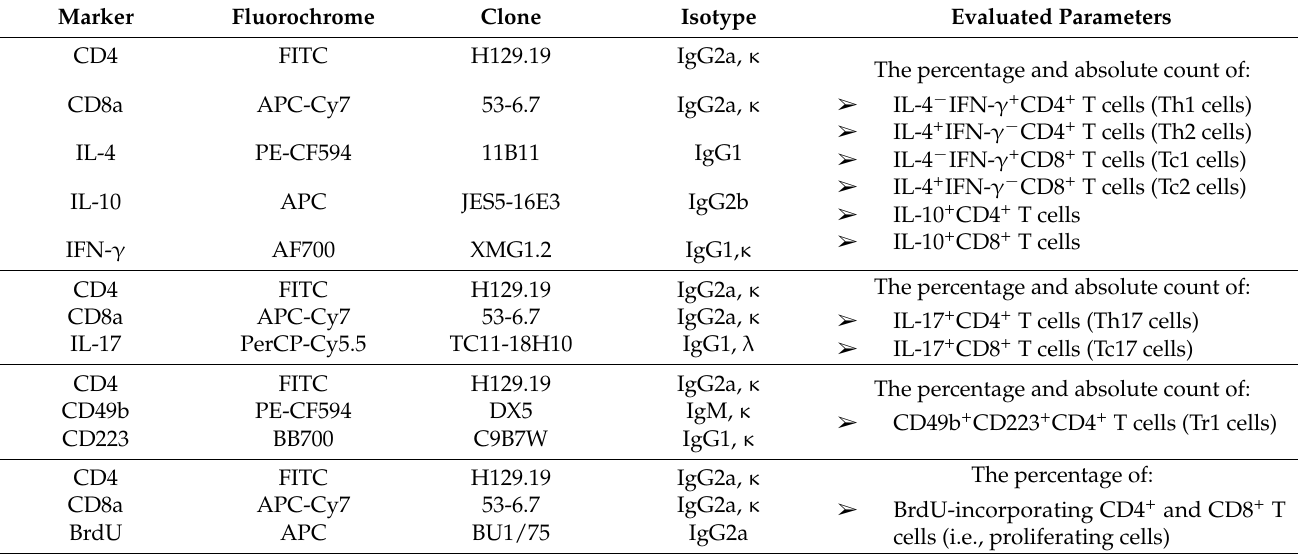
Table 1. The staining combinations, characteristics of monoclonal antibodies and evaluated